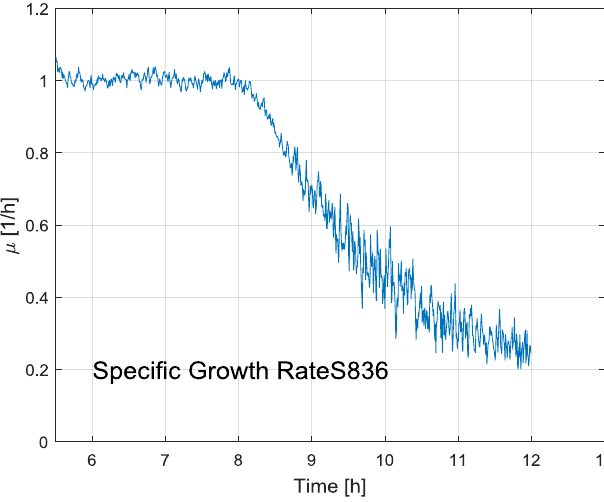
Figure 5. Estimation of the specific growth rate during the cultivation run S836.